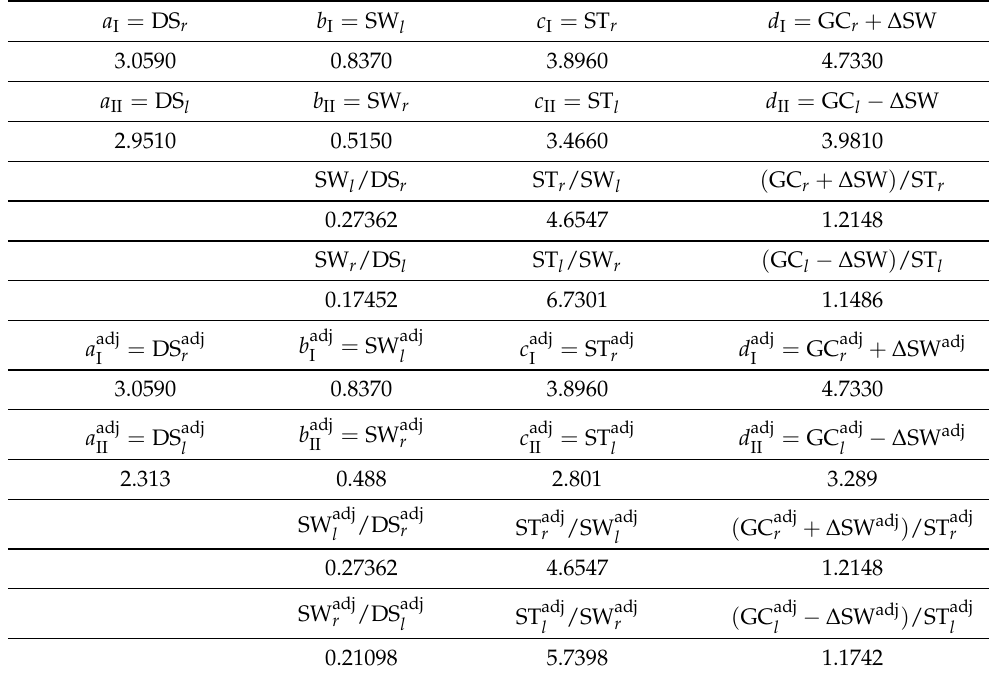
Table 2. Experimental data concerning the elements (in seconds) of the sequences I and II in (3) and their adjoint versions I adj , II adj in (4) for the AT patient F (DS x = 1.292 s, DS y = 1.767 s).